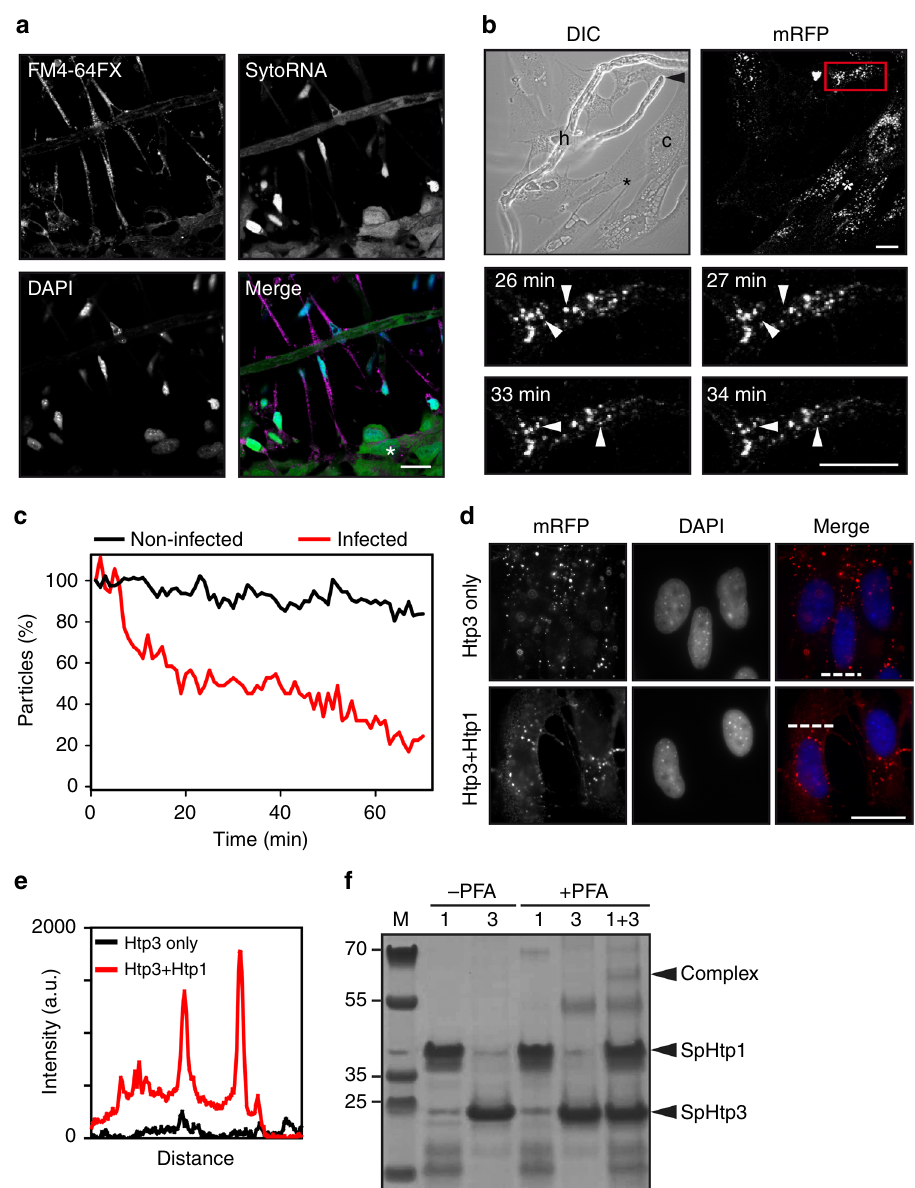
Fig. 7 SpHtp3 is released from vesicles with the help of SpHtp1 from S. parasitica . a RTG-2 cells in direct contact with S. parasitica are shrunk with a condensed nucleus. In these cells, no cytosolic RNA (SytoRNA) can be detected and infected cells contain a high amount of vesicles (membrane stain FM4-64FX, see also Fig. 1b). In contrast, cells in close proximity but no direct contact do not show any morphological abnormalities (*). Scale bar: 20 µ m ( n = 3). b RTG-2 cells (c) were challenged with S. parasitica (h) after 1 h incubation with SpHtp3-mRFP. A hyphal tip (arrowhead, DIC) is attacking an RTG- 2 cell. Magni fi cation of the infected cell (red square) at different time points (bottom) show vesicles disappearing within a minute (arrowheads). See also Supplementary Movie 1. In contrast, cells in close proximity but no direct contact to S. parasitica contain less disappearing vesicles (*). Scale bar: 20 µ m ( n